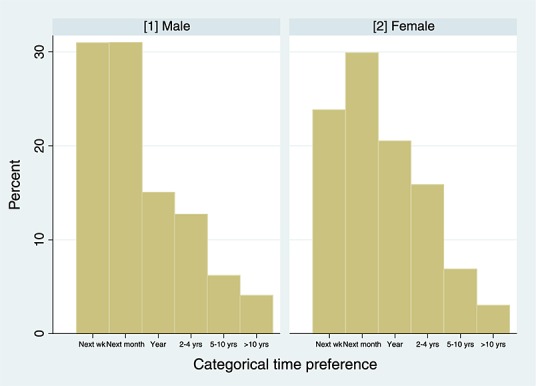
Distribution of time preference variable for young adults separated by gender